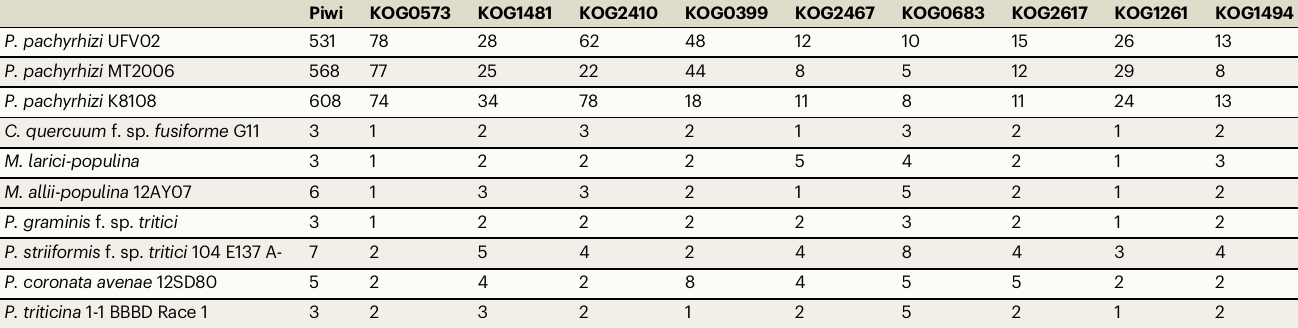
Table 2 | Expansion of gene families in the P. pachyrhizi